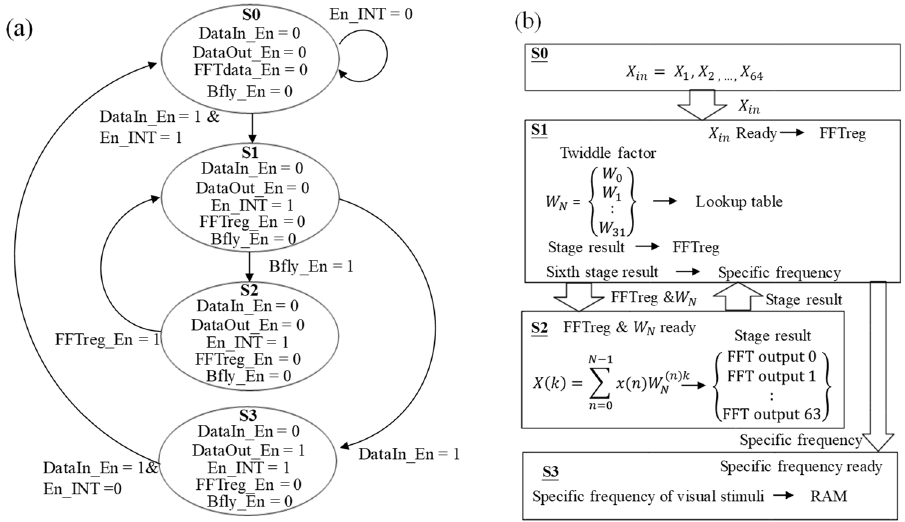
Figure 7. ( a ) State machine and ( b ) data flow of SSVEP BCI.